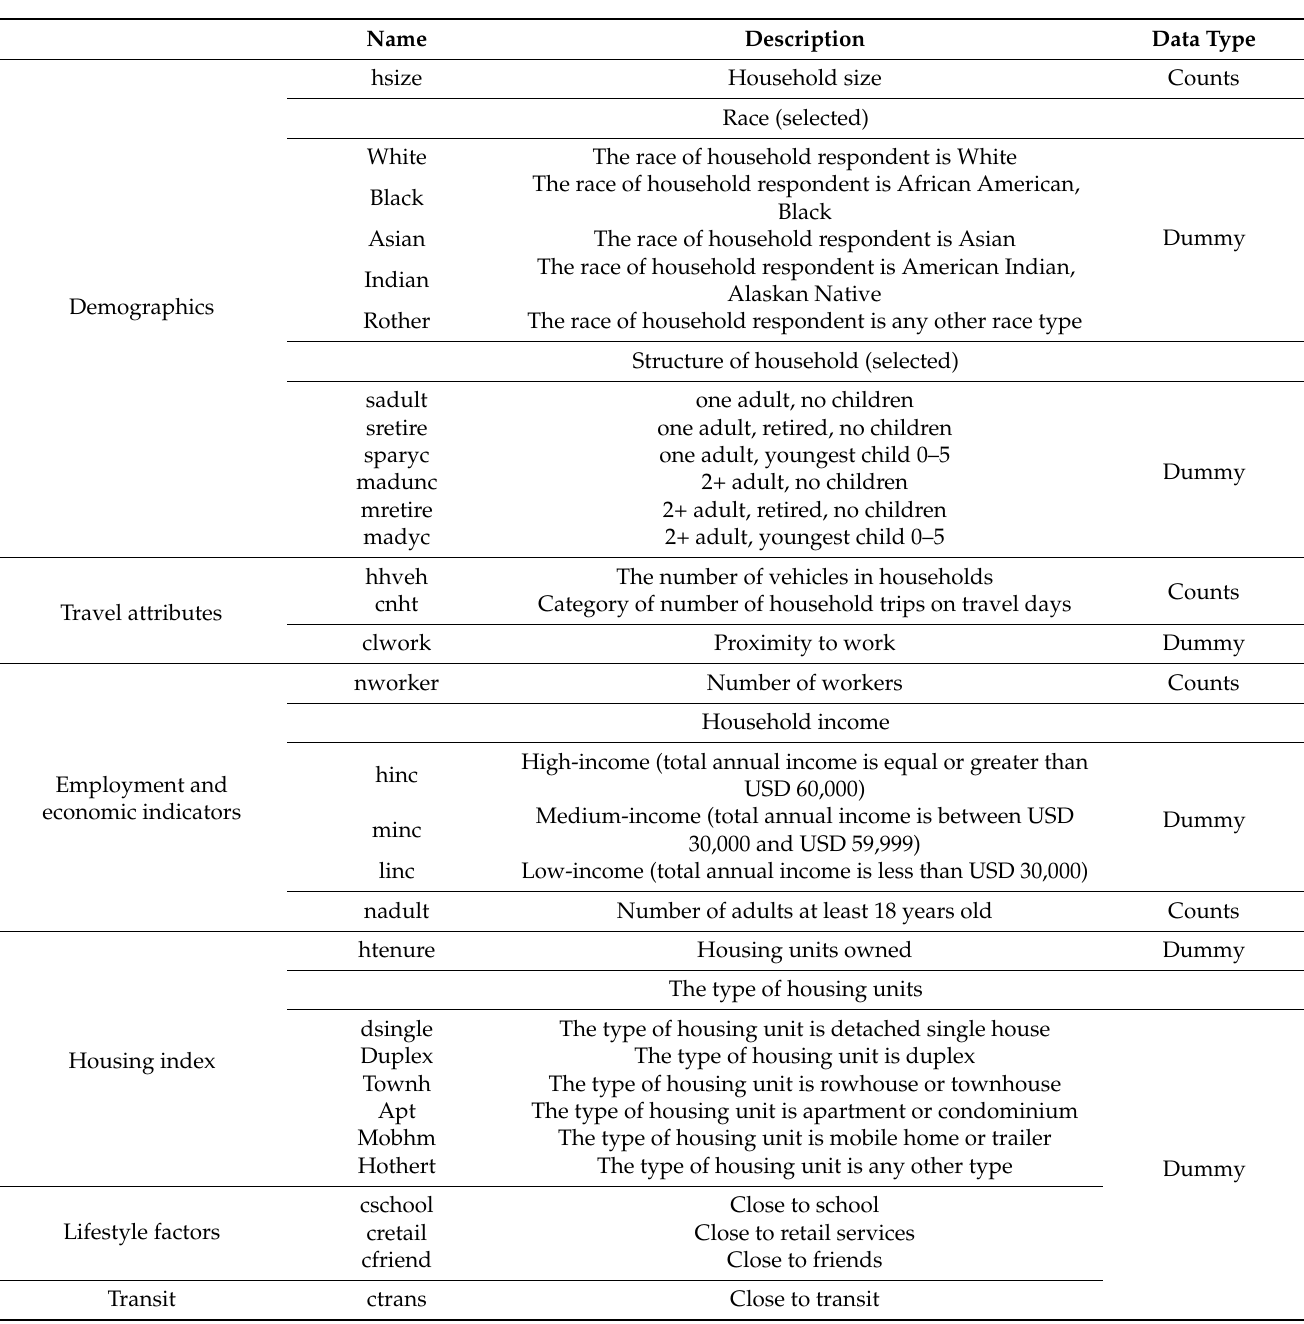
Table 3. Description of selected explanatory variables in the data